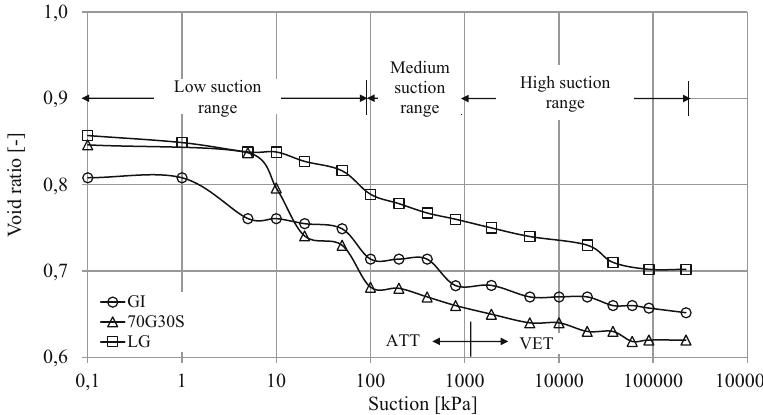
Figure 3: Variation of void ratio with applied suction in SWCC test - drying path results for GI, 70G30S, and LG soil samples.